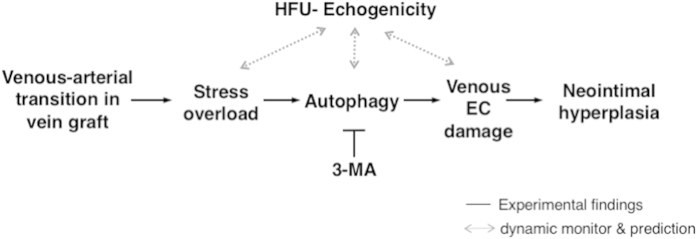
Summary diagram on the monitoring of vein graft progressions by HFU-echogenecity.The prediction of mechanical overload with the consequent induction of EC damage is confirmed by the triggering of autophagic cell death, which can be prevented by the transient administration of 3-MA prior to the venous-arterial transition.